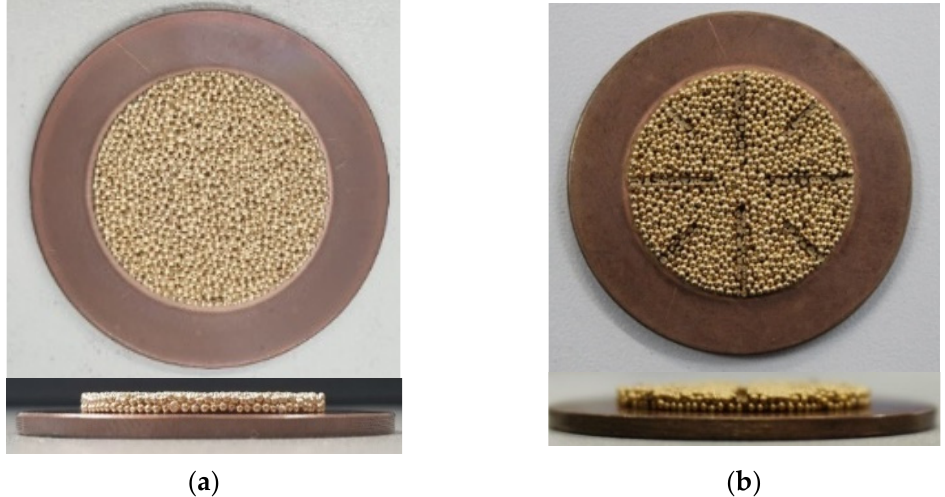
Figure 3. Porous structure on CuCrZr plate: ( a ) original shape; ( b ) version with channels.